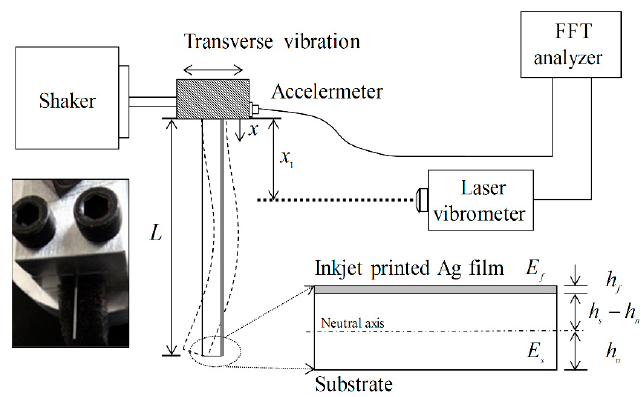
Figure 2. Experimental set-up to measure wave propagation on the specimen. The inset shows a cross section of the specimen bilayer structure. FFT: Fast Fourier transform.